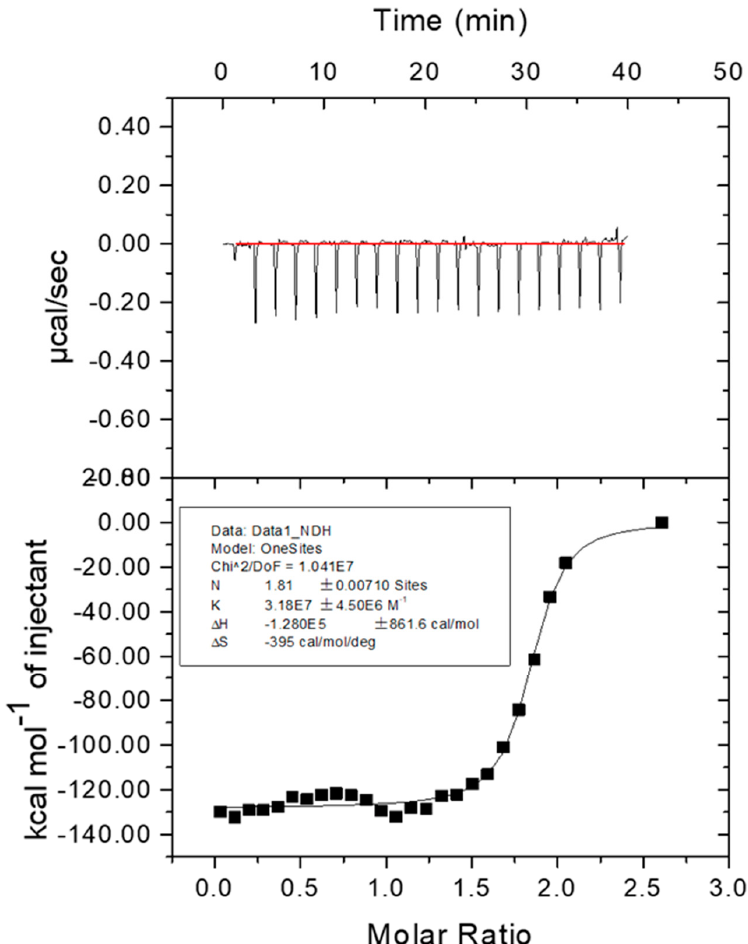
Figure 8. Isothermal titration calorimetry for the interaction of Fe 2+ and Melac13220. Experiment conditions: C Fe2+ = 1 × 10 − 4 M, C Melac13220 = 6.3 × 10 − 6 M, T = 298 K. Purified Melac13220 with different concentrations of Fe 2+ (0.01~0.47 mM) was scanned